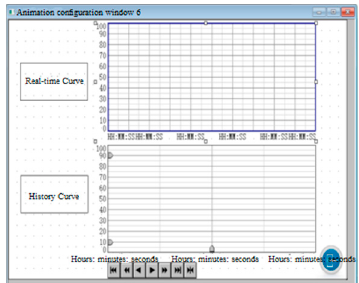
Figure 14. Schematic diagram of the sub-interface.